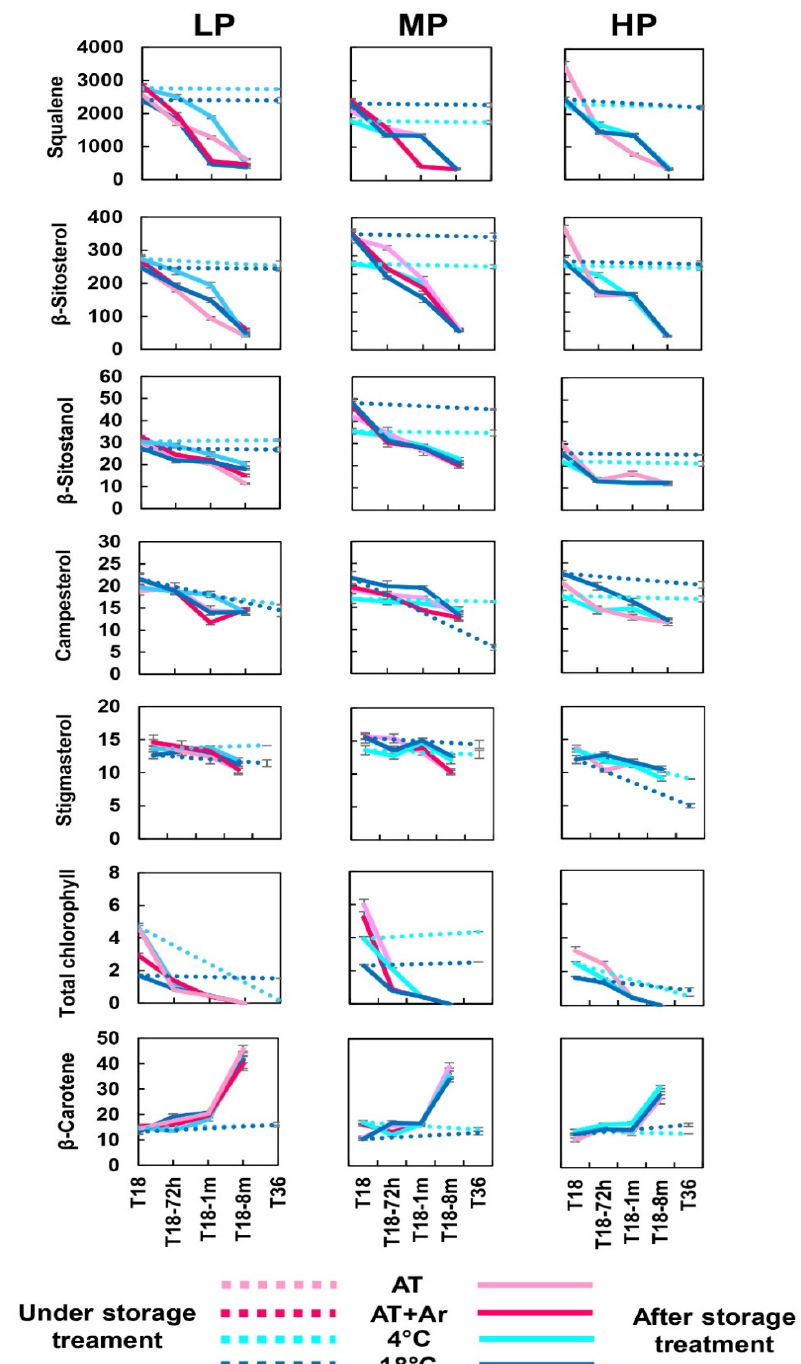
Figure 3. Changes of squalene, sterols, chlorophyll, and β -carotene in LP, MP, and HP EVOOs under different storage conditions and time points. Dot lines: T18 and T36 (under storage treatment); solid lines: T18-72 h, T18-1 m, and T18-8 m (after storage treatment). All values are expressed in mg kg − 1 . Bars represent means ± SD of three replicates.